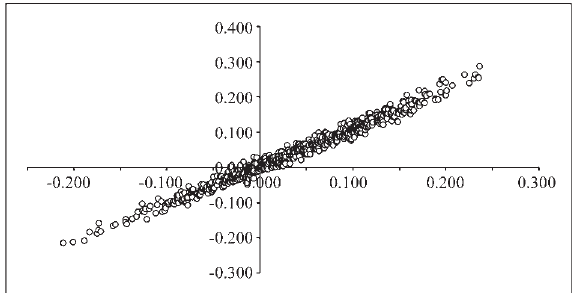
Figure 2 - Relationship between the animals’ estimated breeding values for number of flies counted (FC; x axis) and number of flies in photo- graphs (FF; y axis).